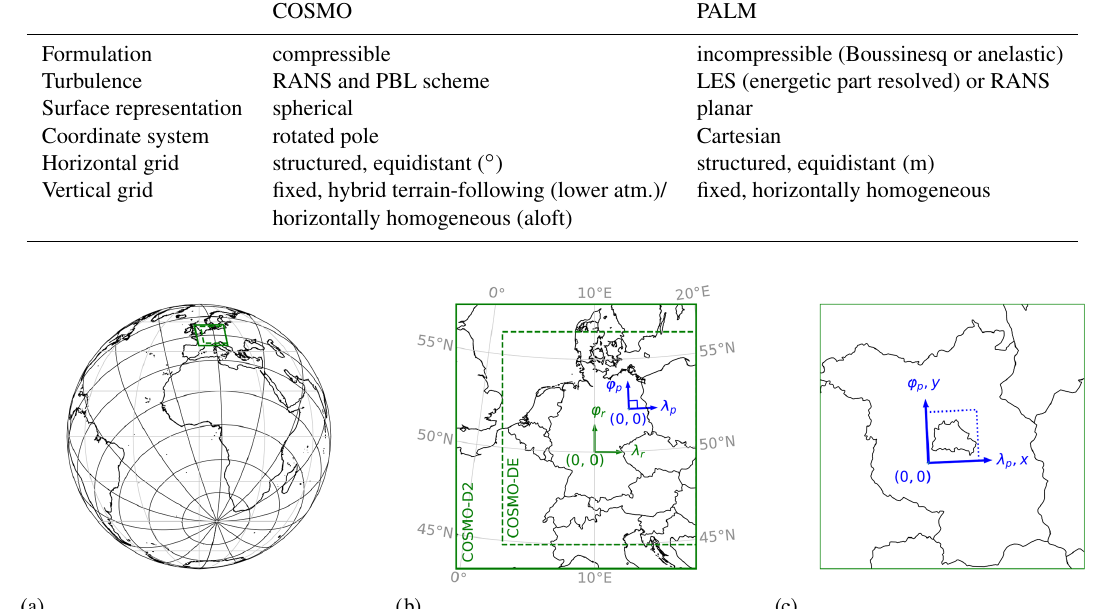
Figure 2. Example PALM domain (blue) for Berlin nested within the DWD COSMO configurations (green). Panel (a) shows the rotated-pole system of COSMO-DE and -D2, the rotated north poles of which are both located at (λ N ,ϕ N ) = ( 170 ◦ W , 40 ◦ N ) , placing their origin at (λ,ϕ) = ( 10 ◦ E , 50 ◦ N ) (see panel b ). Panel (b) shows the horizontal domain extents of both COSMO configurations. COSMO-D2 extends over λ r ∈ [ 7 . 5 ◦ W , 5 . 5 ◦ E ] ,ϕ r ∈ [ 6 . 3 ◦ S , 8 . 0 ◦ N ] (solid green), which is slightly increased compared to the COSMO-DE domain with λ r ∈ [ 5 . 0 ◦ W , 5 . 5 ◦ E ] ,ϕ r ∈ [ 5 . 0 ◦ S , 6 . 5 ◦ N ] (dashed green). Panels (b) and (c) show an example configuration with a PALM domain of 50km × 50km (dashed blue).